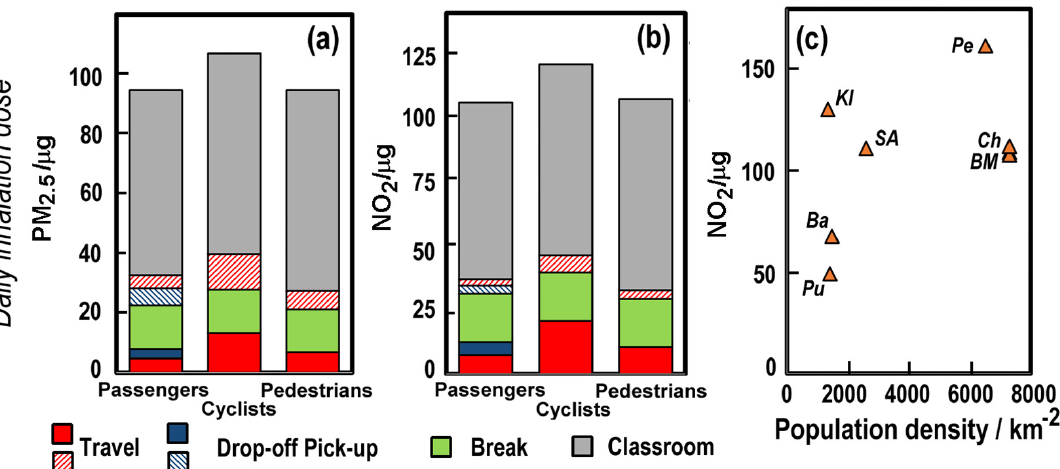
Figure 5. Daily inhalation dose ( µ g) for ( a ) PM 2.5 and ( b ) NO 2 for exposure related to school. Note: hatched shading denotes afternoon exposure. ( c ) vehicular NO 2 exposure as a function of population density for the site locations in Putrajaya (Pu), Petaling Jaya (Pe), Shah Alam (SA), Banting (Ba), Klang (Kl), Cheras (Ch), and Batu Muda (BM).